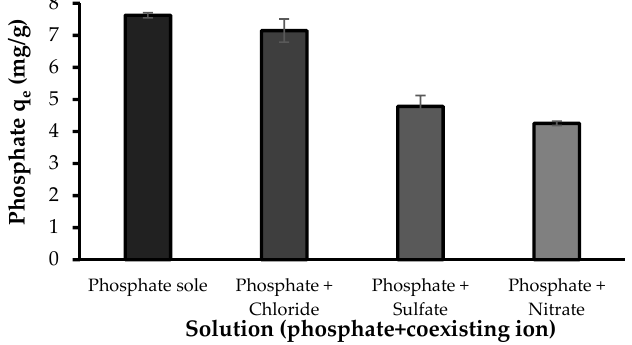
Figure 11. The effect of coexisting ions on phosphate adsorption (Experimental conditions: 5 mg/L phosphate concentration; 5 mg/L coexisting ion concentration; 0.5 g/L Zn(II)–CTS dose; pH 4; 24 contact time).